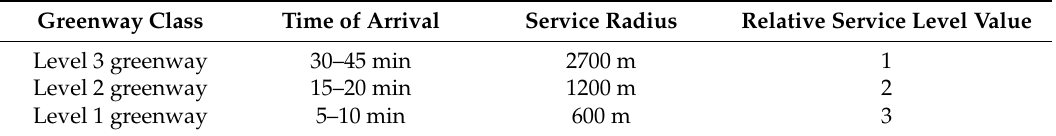
Table 1. Buffer attribute